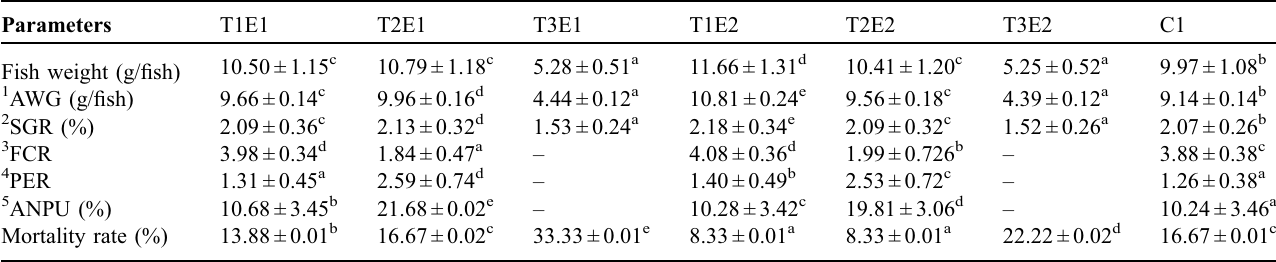
Table 4. Growth response and mortality rate (Mean ±Standard error) of C. carpio in bio fl oc system. Parameters T1E1 Fish weight (g/ fi